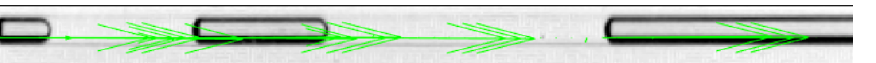
Figure 26. Distribution of velocity vector along the pipe in the experiment with 100 W input power and ethanol as working fluid—52.6% filling ratio.